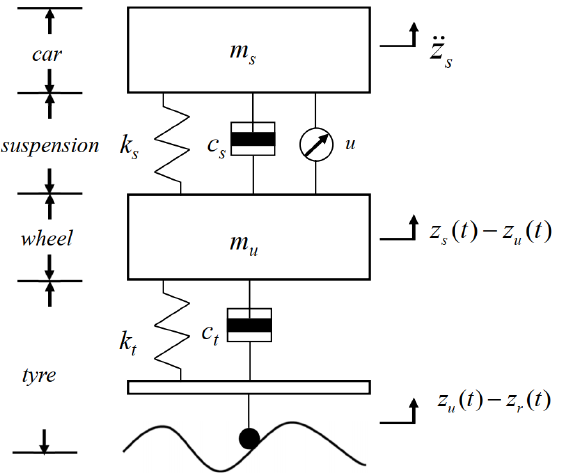
Figure 1. Active suspension model